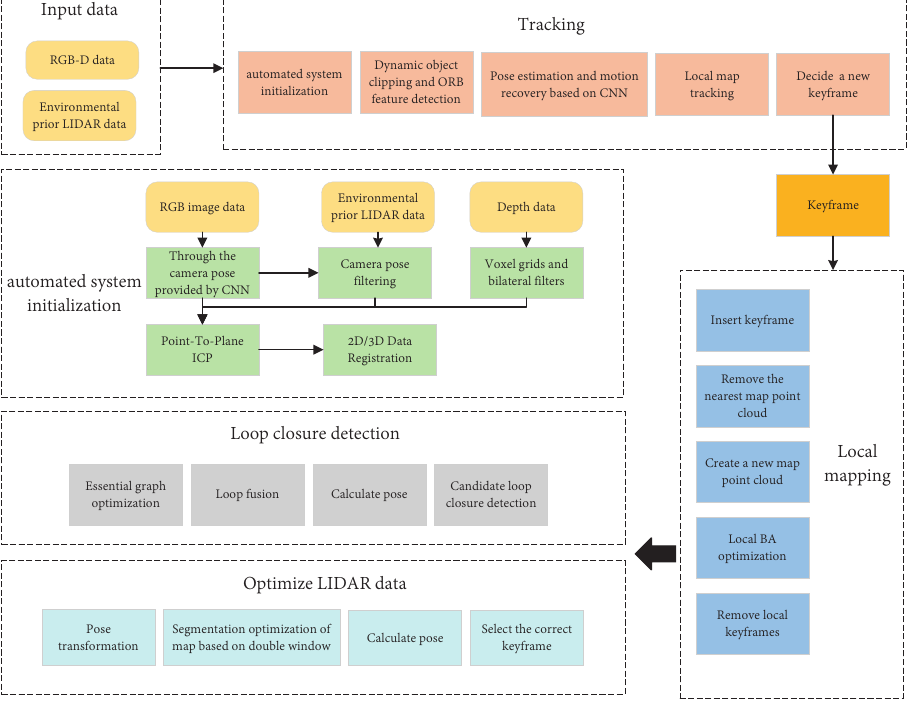
Figure 24. Flowchart of the CNN-based LIDAR–depth camera fusion